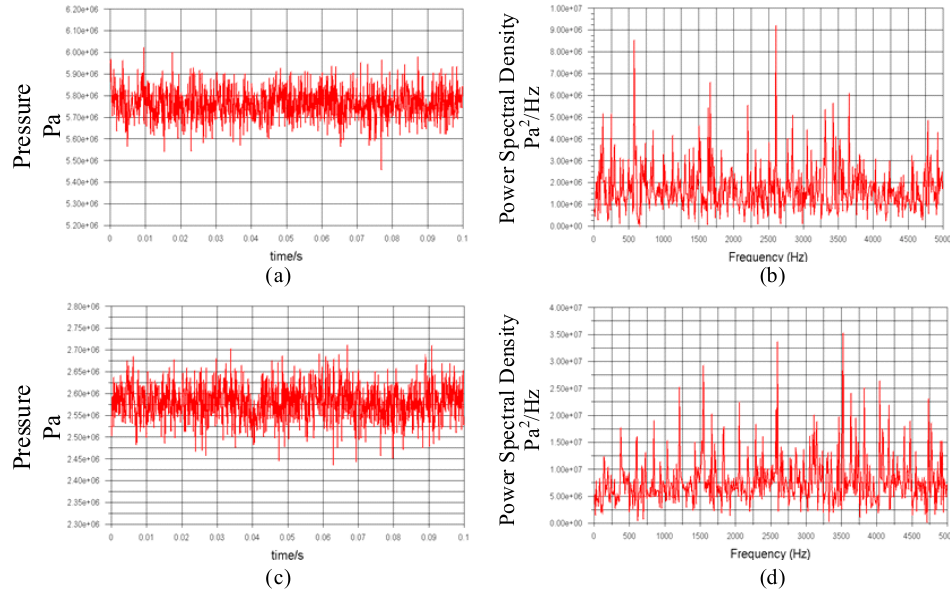
Figure 13. Pressure oscillation curve of the flapper when the displacement of the flapper is x = 0.05 mm. ( a ) Point 1 in the time domain. ( b ) Point 1 in the frequency domain. ( c ) Point 2 in the time domain. ( d ) Point 2 in the frequency domain.